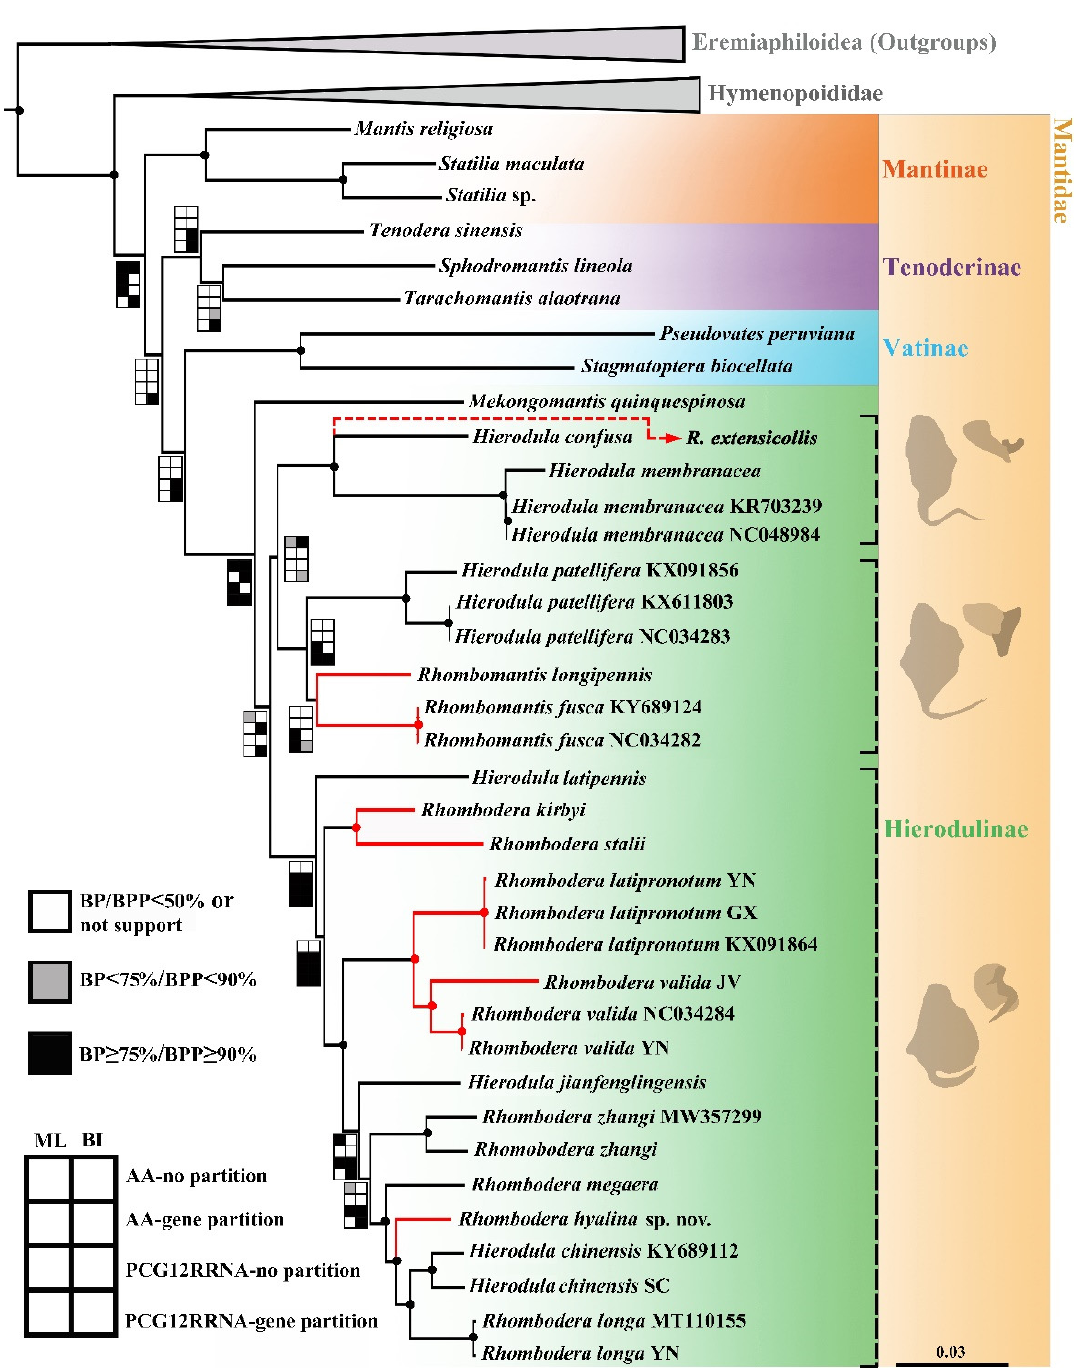
Figure 6. Phylogeny of Hierodulinae from PCG12RNA-gene partition under BI. The relationships that are well supported in all eight analyses are marked in a circle at the nodes. Red full line clades indicate pronotal foliaceous mimicry lineage included in our phylogeny, while the red dashed line indicates the putative position of R. extensicollis according to the morphology. The silhouettes in the yellow area are derived from the typical ventral phallomere (the left) and afa on the male genitalia of three Hierodula + Rhomobodera groups. Abbreviations of the location: JV, Indonesia, Java; YN, China, Yunnan; SC, China, Sichuan. The operational taxonomic units without an accession number followed are generated by this study.